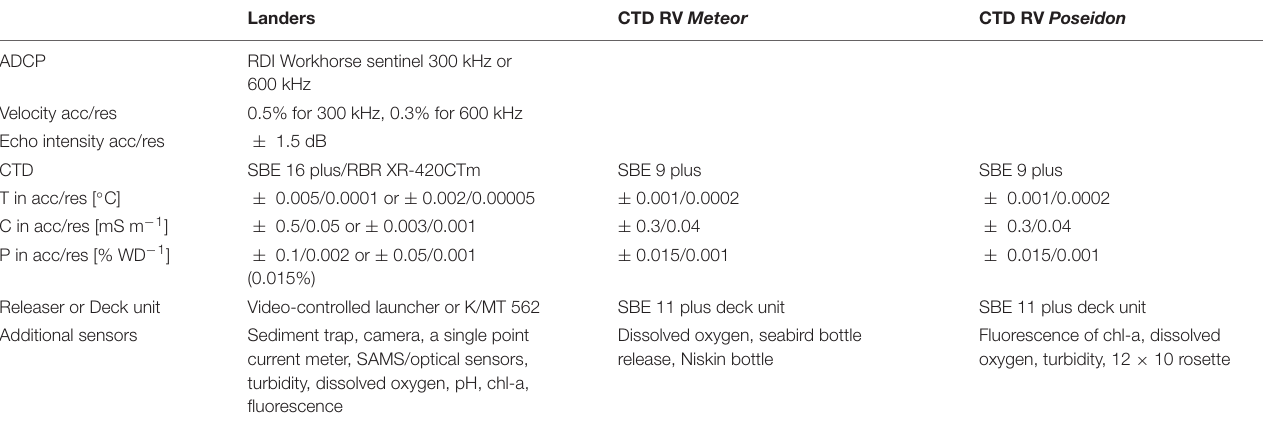
TABLE 3 | Instrumentation details and metadata for landers and onboard